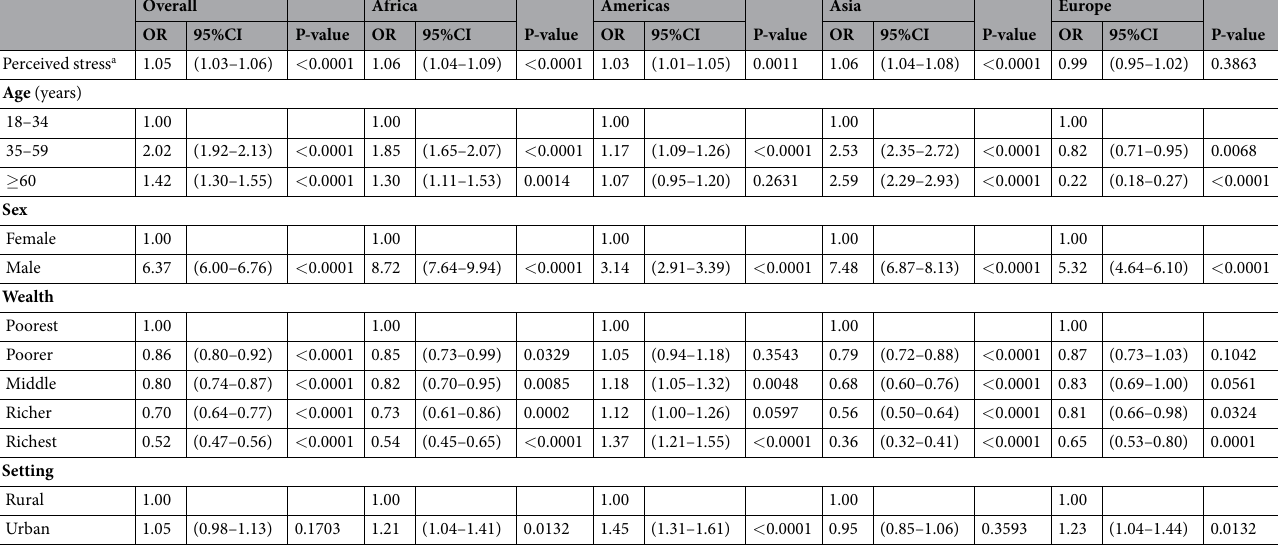
Table 3. Association between perceived stress and smoking (outcome) estimated by multivariable logistic regression. Abbreviation: OR odds ratio; CI confidence interval. a The perceived stress score ranged from 2–10 with higher scores corresponding to higher levels of perceived stress. Models are adjusted for age, sex, wealth, setting, and country.